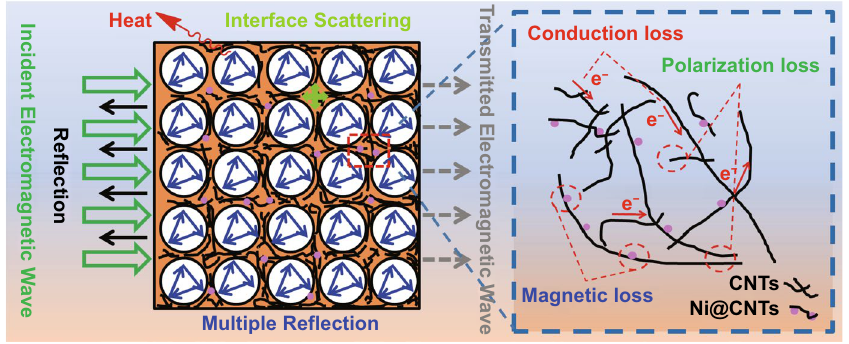
Fig. 10 Schematic description of the microwave transfer across the TPU composite